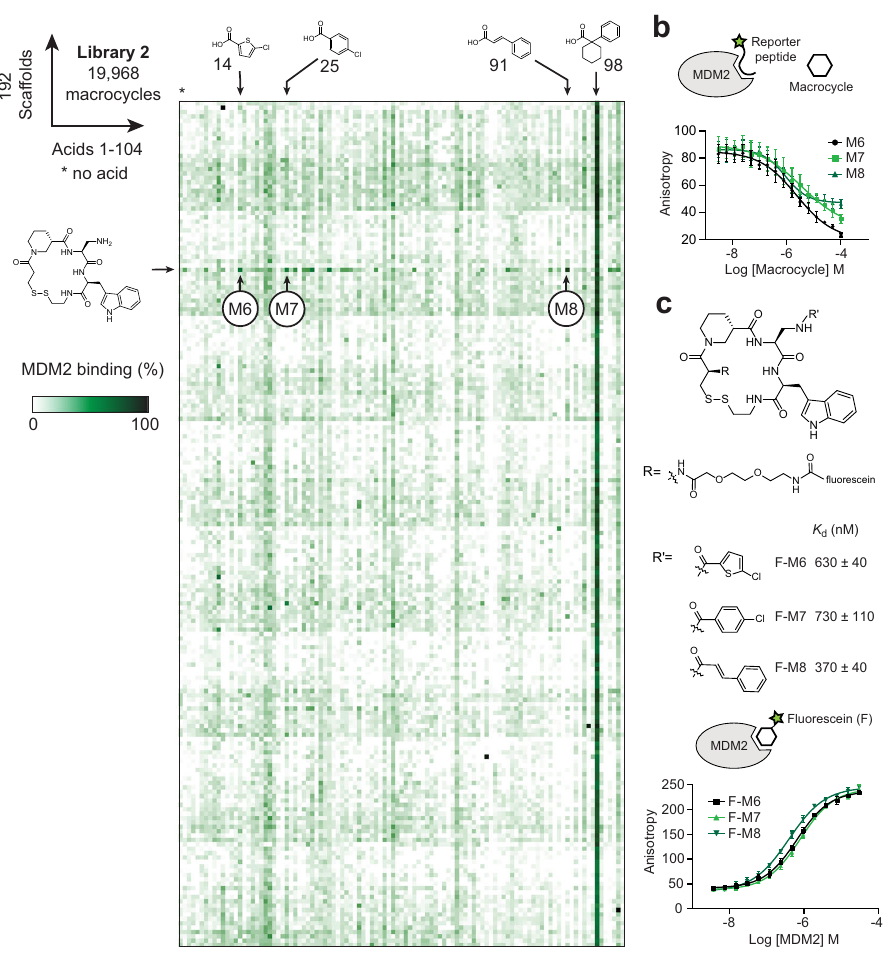
Fig. 4 Screen against MDM2 and hit characterization. a The 192 macrocycle scaffolds (Supplementary Fig. 9) were combinatorially acylated with 104 carboxylic acids. The products were screened for displacement of a p53-based fl uorescent peptide from human MDM2. Final macrocycle concentrations were 10 µ M. For each macrocycle, the MDM2 binding was measured once. The amino acid sequences of the scaffolds are provided in Source Data fi le. b Displacement of the fl uorescent reporter peptide from MDM2 by HPLC-puri fi ed hit macrocycles M6 – M8 measured by FP. Mean values and SDs from three independent displacement assays are shown. c Chemical structures of fl uorescein-labeled M6 – M8 that were measured for af fi nity to MDM2 in a direct binding assay by FP. Mean values and SDs from three independent measurements of the binding by FP are